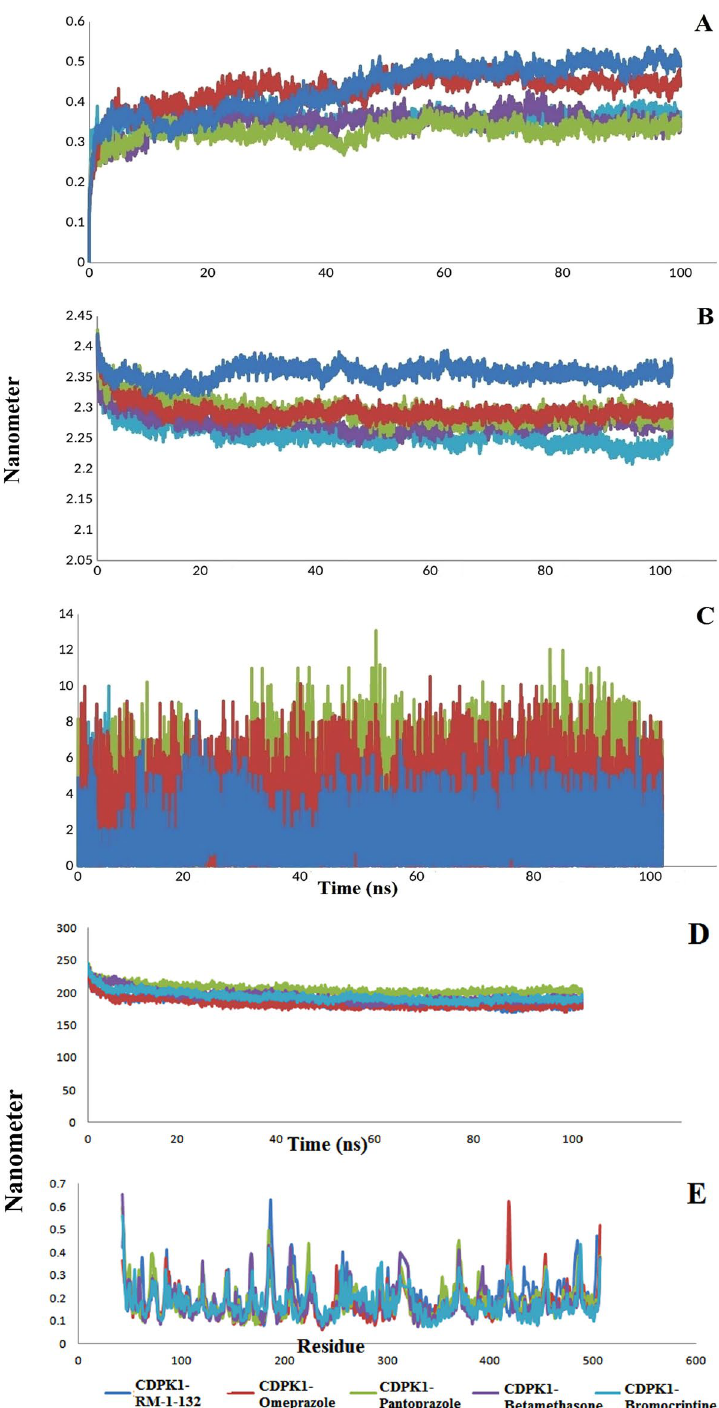
Figure 6. ( A ) RMSD values of CDPK1 docked complexes. ( B ) Rg values of CDPK1 docked complexes. ( C ) Number of H-bonds of CDPK1 docked complexes. ( D ) SASA values of CDPK1 docked complexes. ( E ) The RMSF values of CDPK1 protein in the simulated complexes compared to CDPK1-RM-1–132 complex as and OPLS-AA force field 43 . Docked complexes were selected and placed in a triclinic box with a distance of 1 nm from all edges 44 . The topology parameters for the protein structure were prepared by the GROMACS program. Topology preparation and configuration parameters of each ligand were used using the PRODRG server. After that, drug–protein complexes were immersed in a simulation box filled with SPC (Simple Point Charge) water molecules 45 . To neutralize the simulation box in terms of electrical charge, an appropriate number of ions were